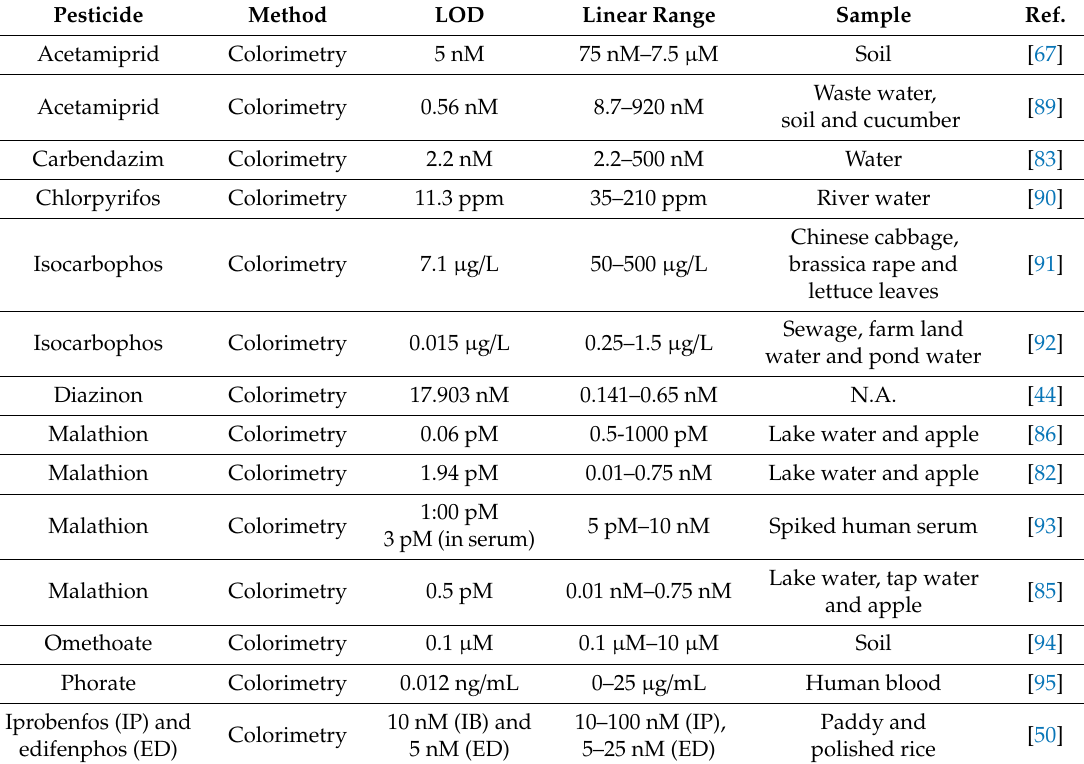
Table 2. Colorimetric aptasensors for pesticide detection. (LOD, limit of